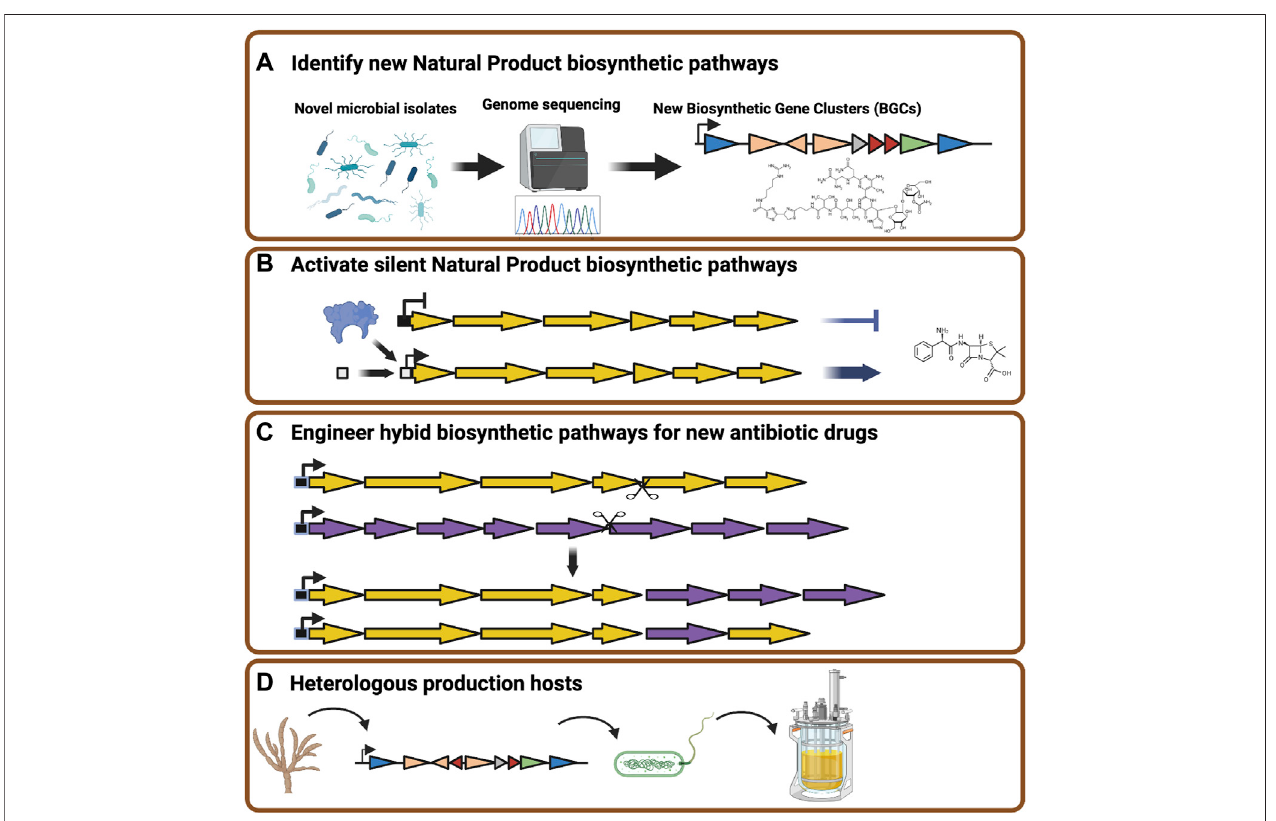
FIGURE 1 | Strategies to expand the diversity of natural product antibiotics. (A) Rapid genome sequencing combined with bioinformatic tools can be applied to a broad range of bacteria and fungi isolated from unusual environments to identify natural product biosynthetic gene clusters. (B) Genome engineering applied to native natural product producing organisms can activate silent biosynthetic gene clusters through modi fi cation of promoter elements or the introduction of transcriptional activators. (C) Synthetic biology and DNA assembly technologies allow for the assembly of hybrid gene clusters to synthesize novel or modi fi ed natural